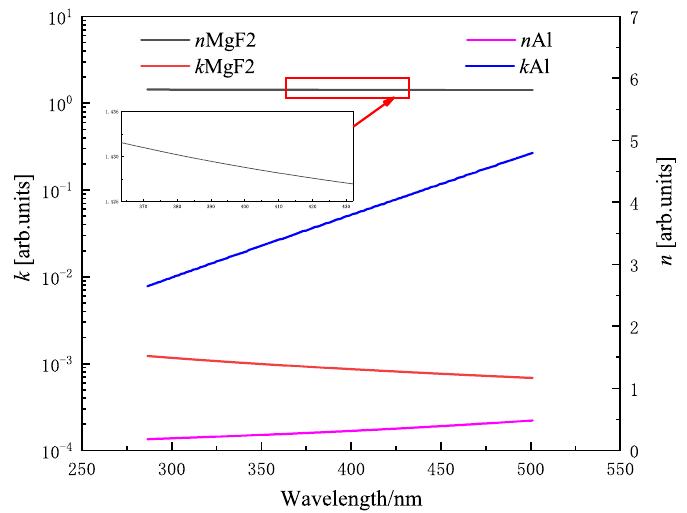
Figure 11. Refractive index and absorptivity of MgF2 and Al with respect to